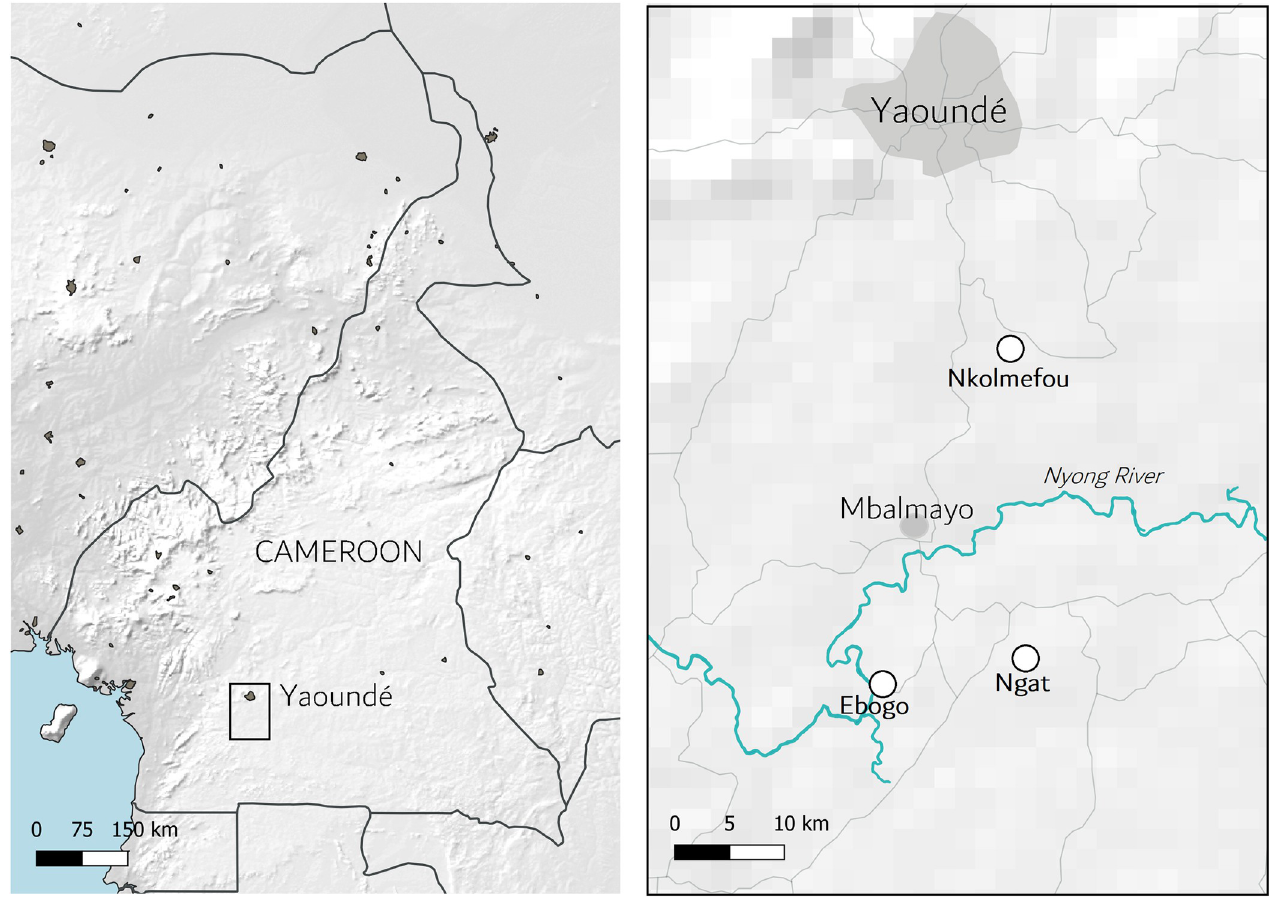
Fig 1. Map of the study area, showing the location of the Nyong river basin and the three villages in which sampling was conducted: Nkolmefou, Ngat, and Ebogo. Made with Natural Earth. Free vector and raster map data @ naturalearthdata.com.